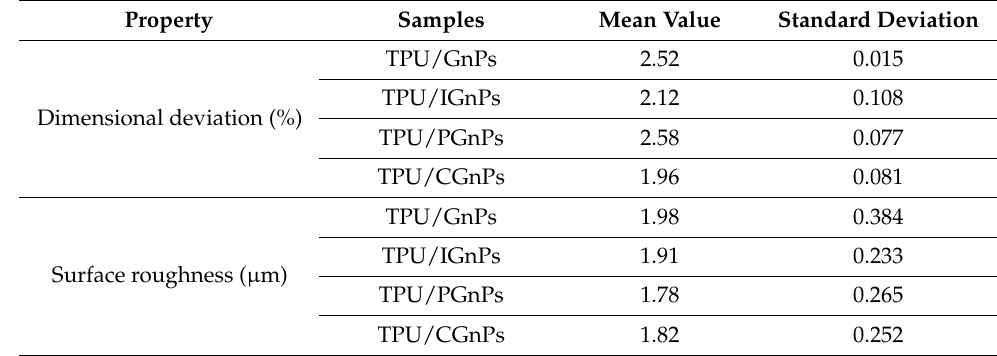
Table 2. Mean value and standard deviation of the dimensional deviation and surface roughness.